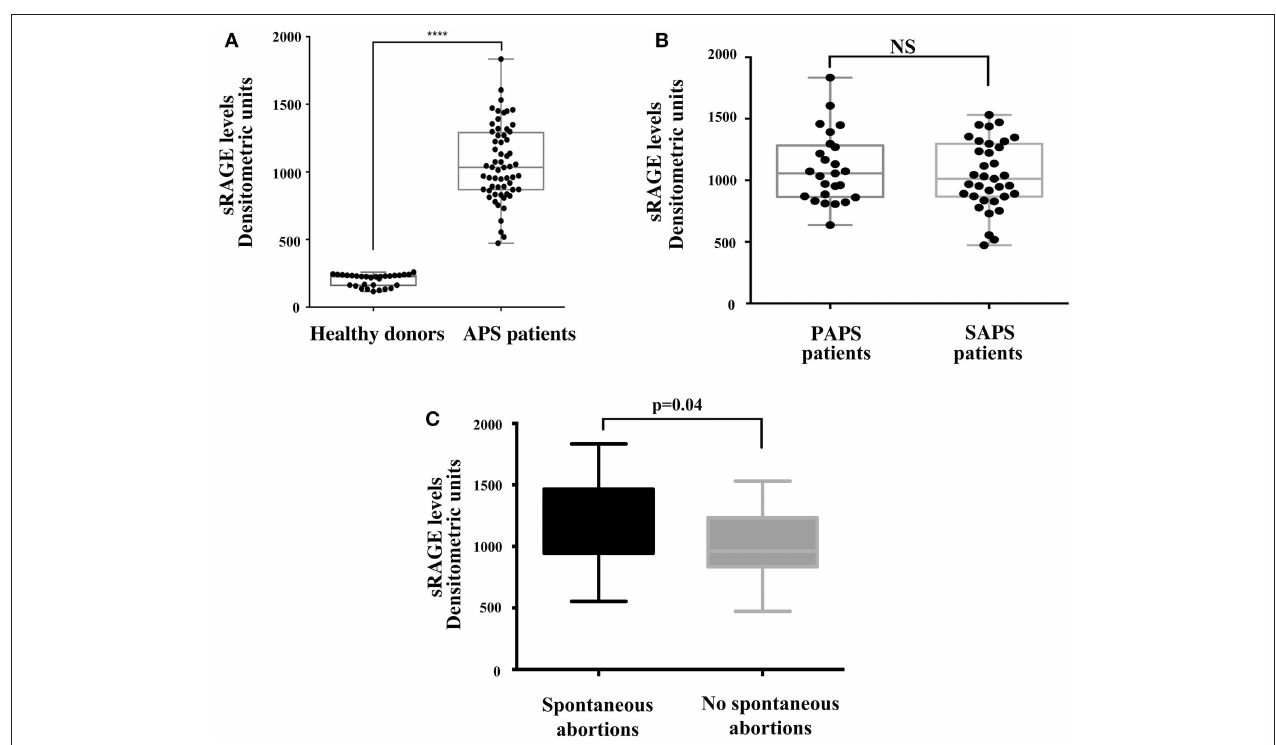
FIGURE 4 | Increase of serum sRAGE levels in APS patients. (A) sRAGE levels were detected by Western Blot in APS patients ( n = 60) and healthy donors ( n = 30) sera, using mouse anti-RAGE mAb. Densitometric values of sRAGE levels calculated in healthy subjects and APS patients are represented and summarized by boxplot statistics. A statistically significant difference between expression of sRAGE in APS patients vs. control subjects was found (**** p < 0.0001). (B) Densitometric values of sRAGE levels calculated in PAPS patients ( n = 25) and SAPS patients ( n = 35) are represented and summarized by boxplot statistics. NS, not significant. (C) Densitometric analysis of sRAGE levels, represented and summarized by boxplot statistics, revealed that patients with spontaneous abortions had significantly higher values than patients without spontaneous abortions ( p =